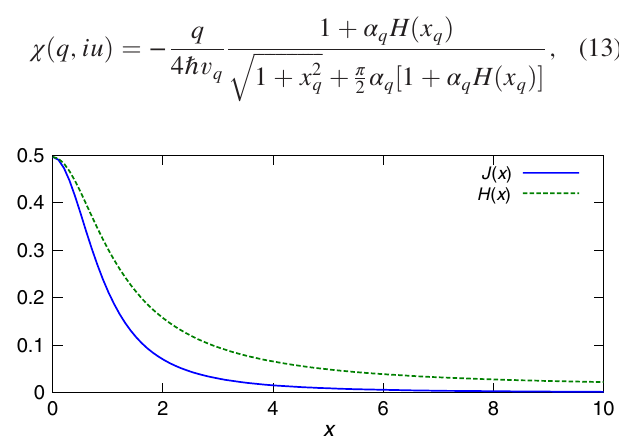
FIG. 2. Numerical fit [Eq. (12)] to the functions J ð x Þ (solid ffiffiffiffiffiffiffiffiffiffiffiffiffi p 1 þ x 2 line) and H ð x Þ ≡ J ð x Þ (dashed line) that control the magnitude of the self-energy and vertex corrections to the RPA beyond the simple renormalization of the